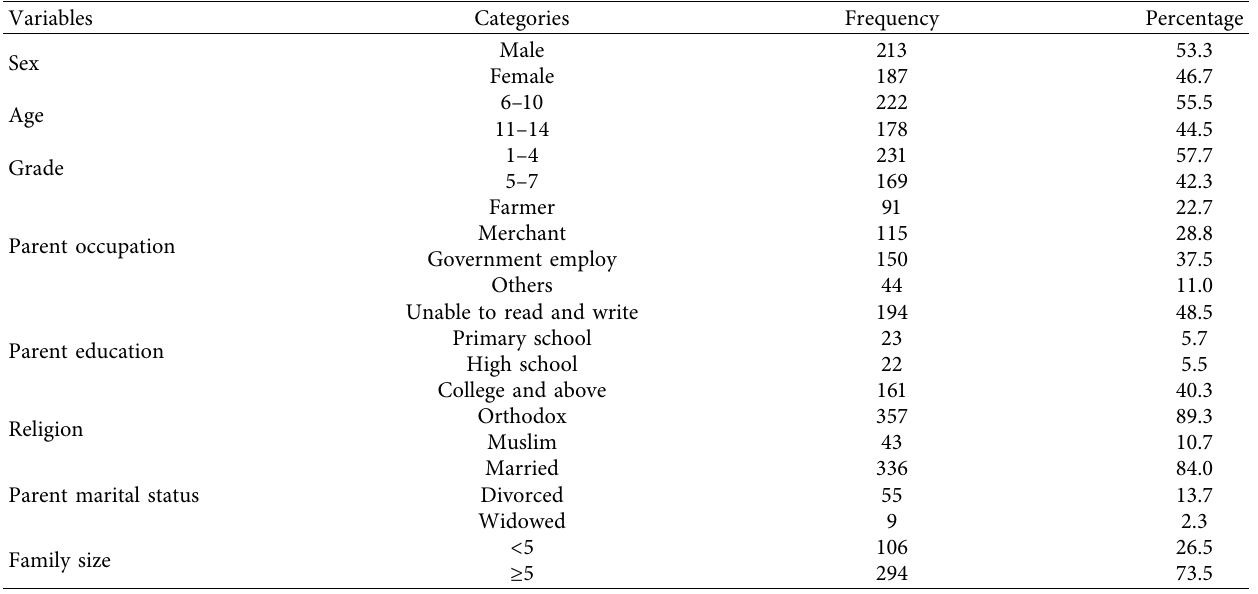
Table 1: Sociodemographic characteristics of school children ( n � 400) at Kola Diba primary school, Northwest Ethiopia. Variables